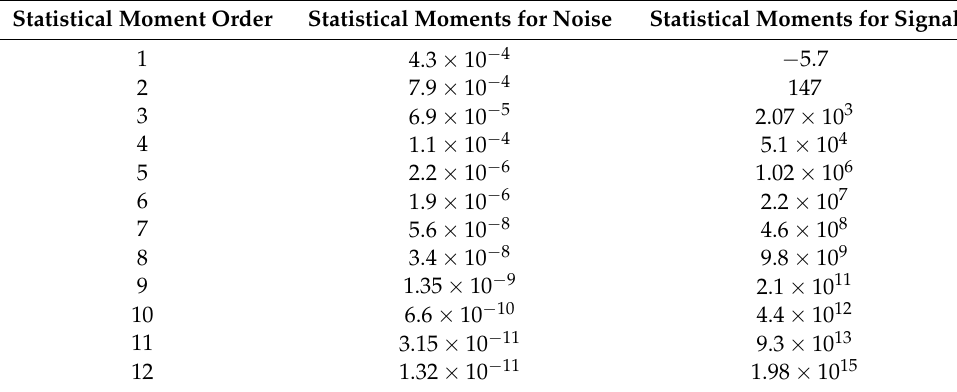
Table 3. Statistical moments for signal and noise.